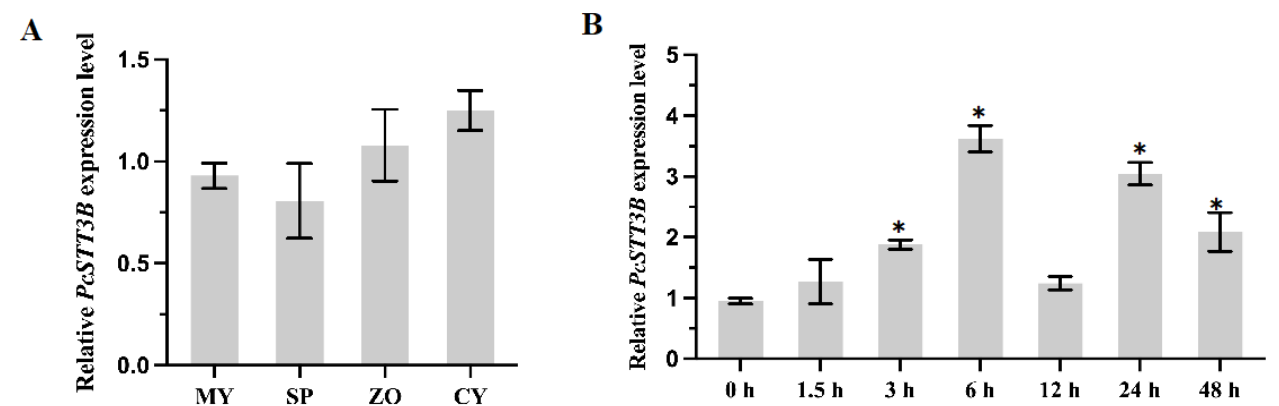
Figure 3. Expression patterns of the PcSTT3B gene at different stages of P. capsici . Relative expression levels of the PcSTT3B gene at the developmental ( A ) and post-infection ( B ) stages were measured by RT-qPCR. MY: mycelia. SP: sporangia. ZO: zoospores. CY: germinated cysts. Measurements were done at 0, 1.5, 3, 6, 12, 24, and 48 h post inoculation. Data represent the mean ± standard deviations from three biological repeats. Asterisks indicate significant differences from the MY or 0 h (*, p < 0.05).